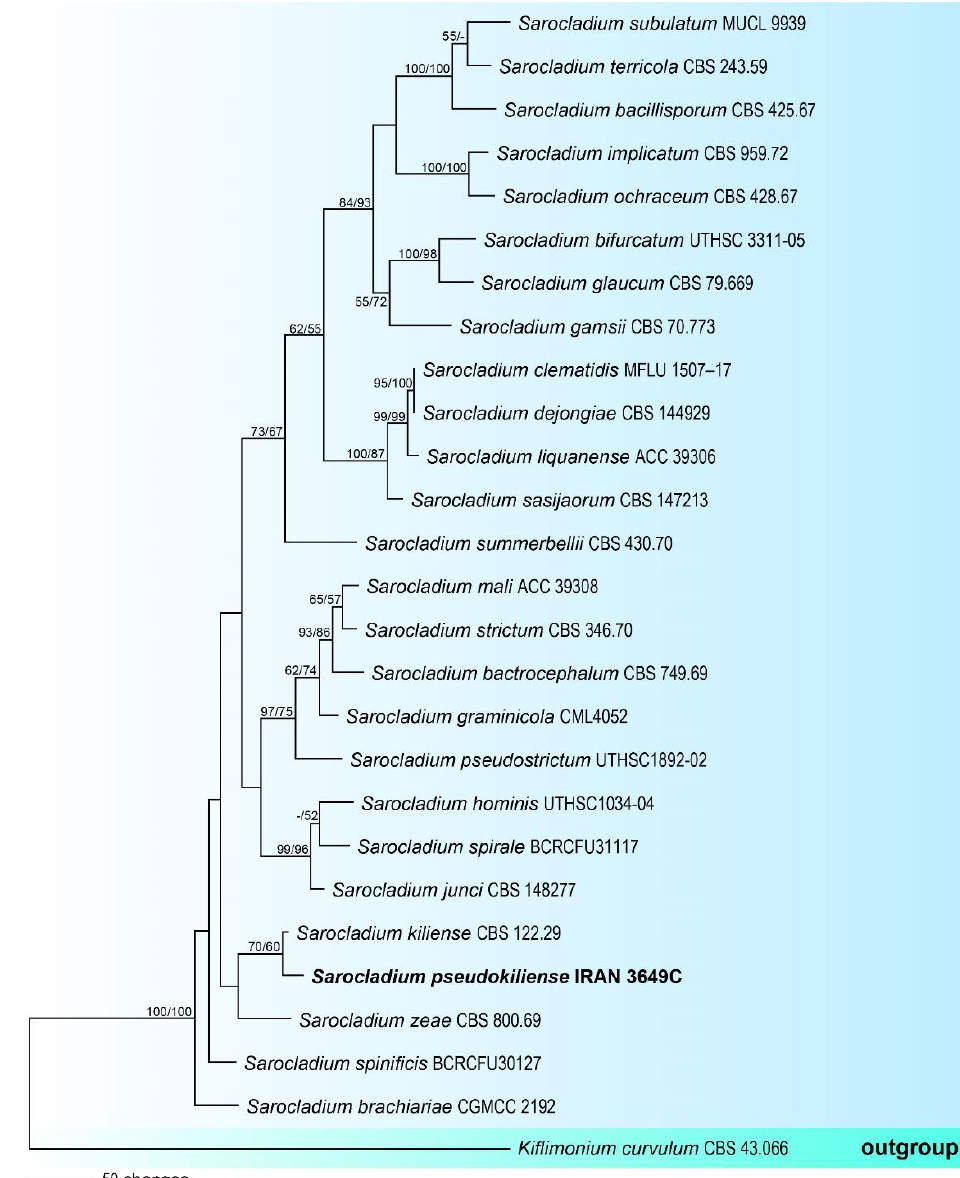
Figure 2. Phylogram showing the single most parsimonious tree revealed by an analysis of the combined ITS – LSU – ACT1 matrix of selected Sarocladium , spp. Values above or below the branches indicate maximum parsimony and maximum likelihood bootstrap support, respectively. Tree statistics: tree length = 1644, consistency index = 0.613, retention index = 0.604, and rescaled consistency index = 0.387.